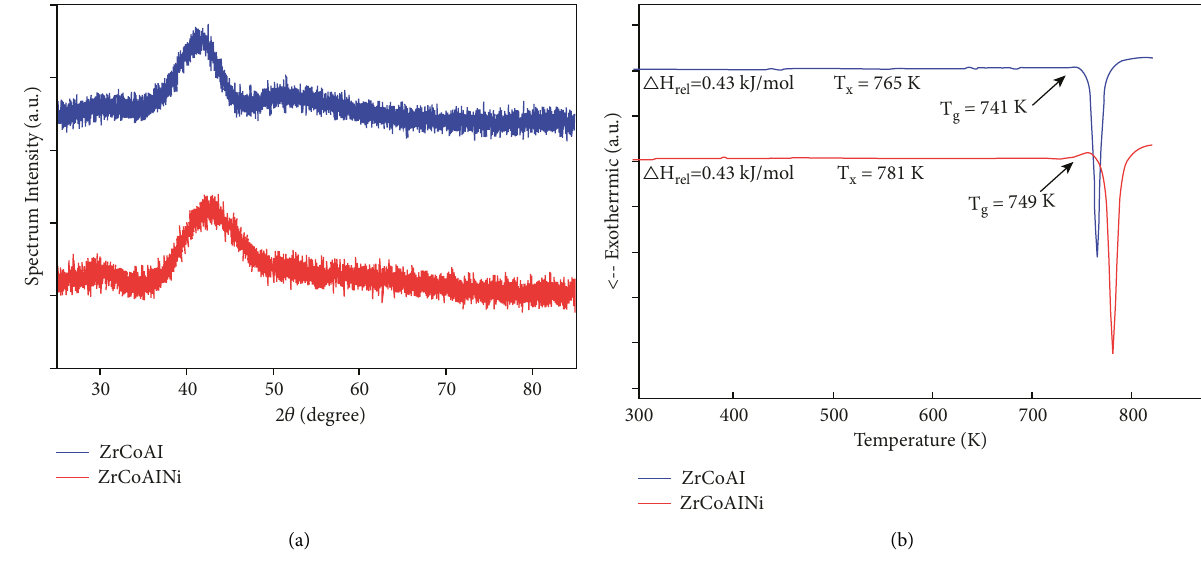
Figure 1: (a) XRD spectra and (b) DSC curves for ZrCoAl and ZrCoAlNi.